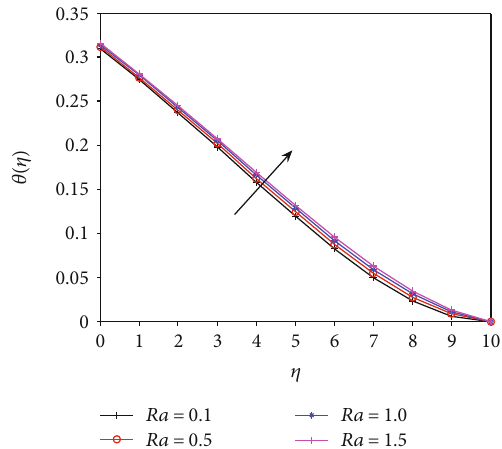
Figure 8: Temperature pro fi les for sundry values of Ra once Pr = 0 : 72 , λ = M = Bi = Gr = 0 : 1 .